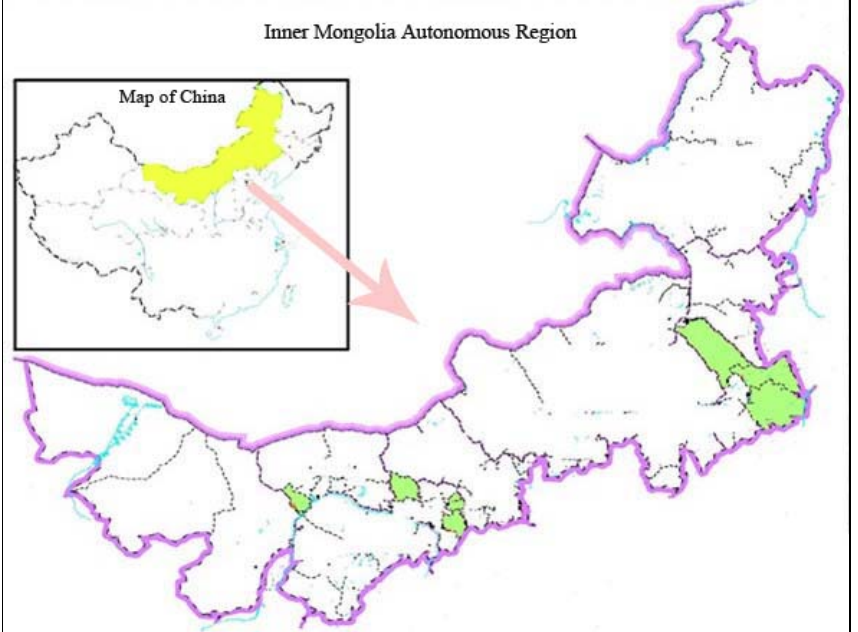
Figure 1. Map of the CDM project (color in green) in Inner Mongolia Autonomous Region, China.